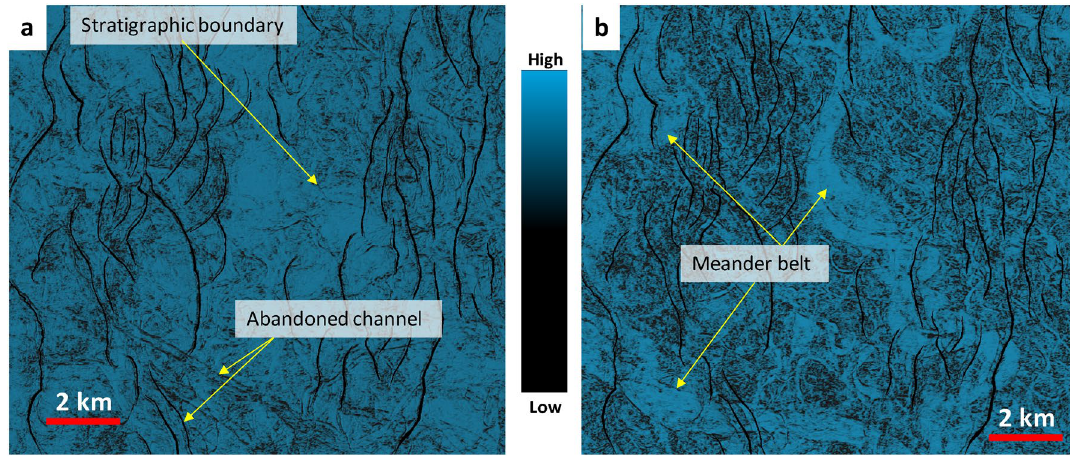
Fig. 7 The semblance map of horizon B+80 ( a ) and B+250 ( b ) (above K horizon). In B+80 slice stratigraphic boundaries and abandoned chan- nels were clearly seen on the semblance slice. In B+250 yellow arrows indicating big meander